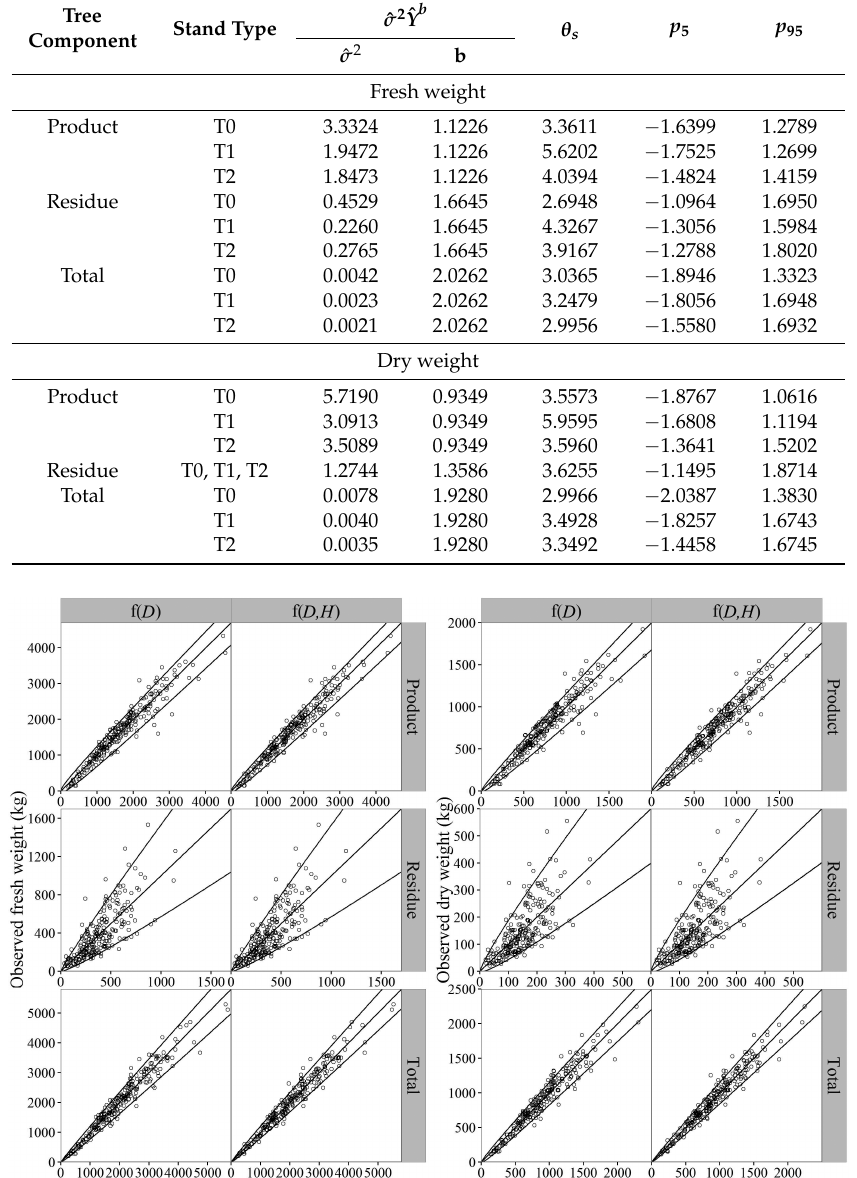
Table 7. Estimated scale factors ˆ σ 2 and exponents of the residual variance functions for product, residue and total tree fresh and dry weight predicted by the system of additive equations with the incorporation of dummy variables for stand types, using D and H as the independent variables Equation (10). θ s is Snowdon’s bias correction factor, p 5 and p 95 are the fifth and ninety-fifth percentiles of the weighted residuals.